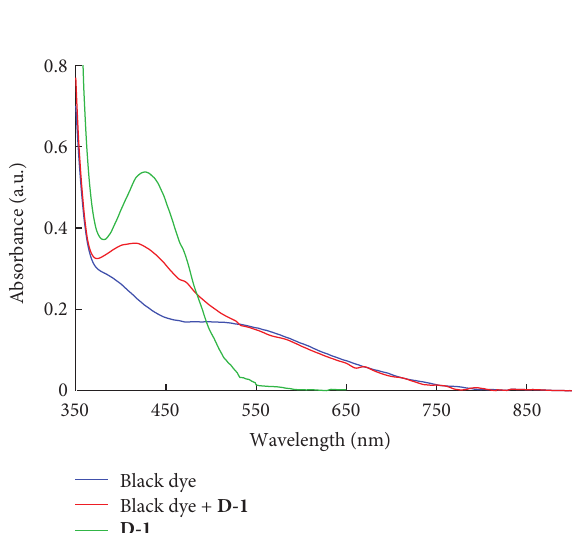
F 1: Chemical structure of dye D-1 and black dye.